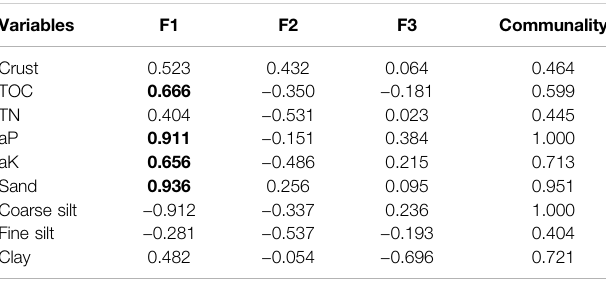
TABLE 6 | Factor loadings and communality of nine soil variables in relation to the three factors. Variables F1 F2 F3 Communality Crust